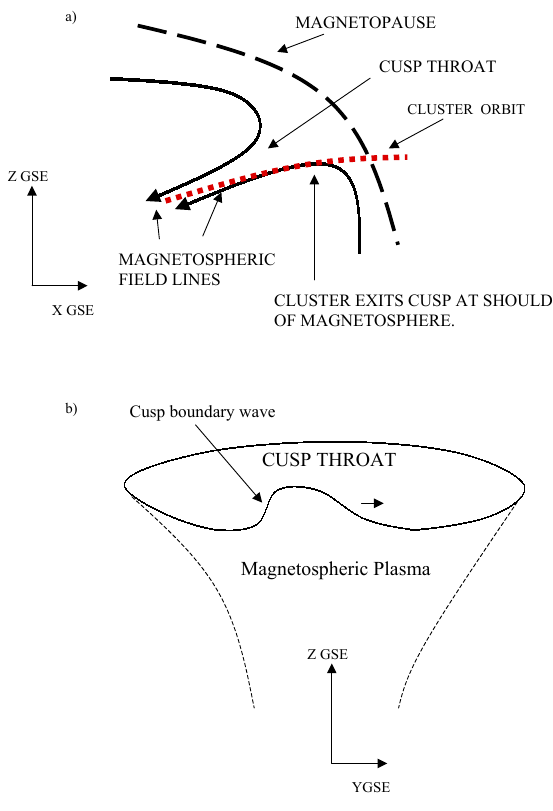
Fig. 15. (a) The diagram shows the cusp viewed from dawn in the X − Z plane, with the solar wind flowing from the right. The ap- pearance of BPS plasma in the cusp suggests an entry into the mag- netosphere, as indicated. However, the different orientation of the entry and exit by Cluster to/from the BPS suggests that the transient entry into the BPS is due to a wave-like structure travelling along the equatorward edge of the cusp as in (b) . Here, we suggest that the rotation of the IMF modifies the equatorward cusp boundary layer, such that Cluster observes a magnetospheric population convecting duskward along the equatorward edge of the